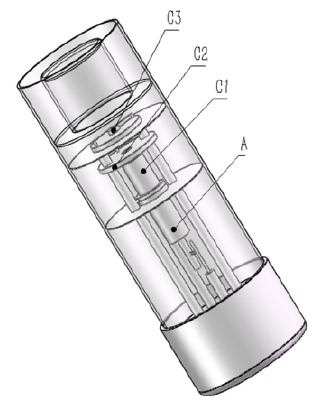
Figure 1. Pb and Cd high-performance composite hollow-cathode lamp. A: anode; C1: Pb–Cd composite cathode; C2: auxiliary cathode; C3: Cu cathode.